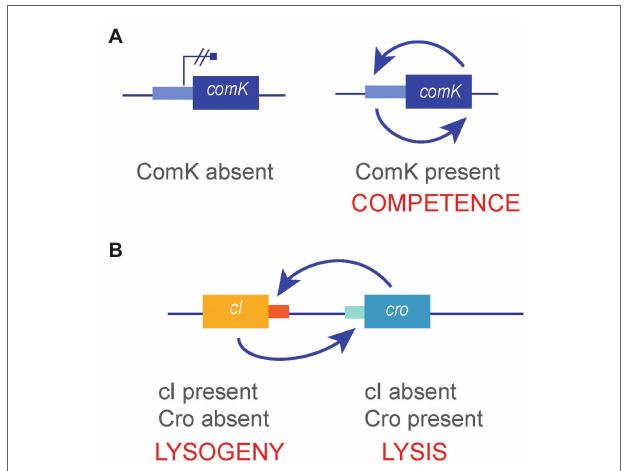
FIGURE 3 | (A) Competence development in B. subtilis , an example of bistability produced by a positive feedback loop. (B) The